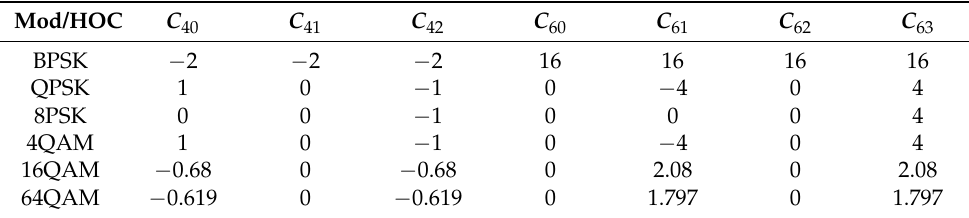
Table 1. Theoretical values of HOCs for some modulation schemes with unity energy.